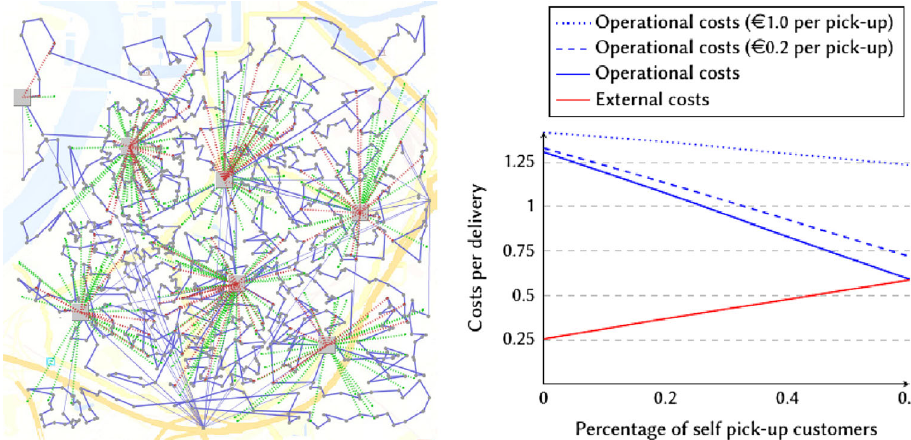
Fig. 4 (left) Delivery routes for a large LSP with self-pick-up. (right) Costs per delivery as a function of the percentage of